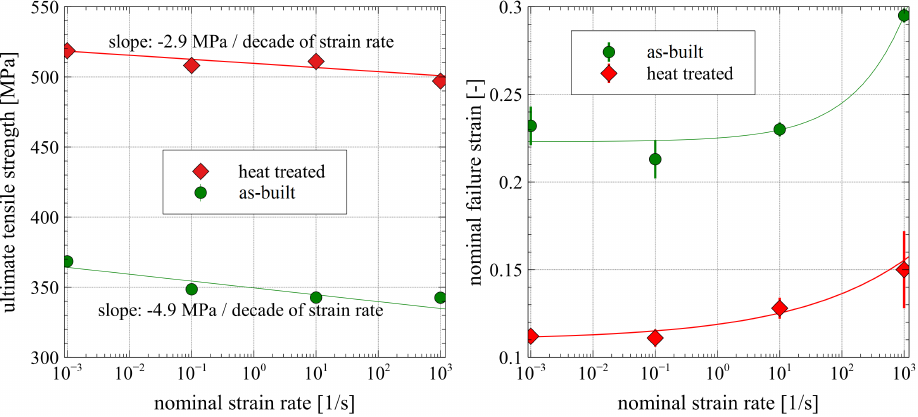
Figure 4. Analysis of the strain rate dependency of ultimate tensile strength and failure